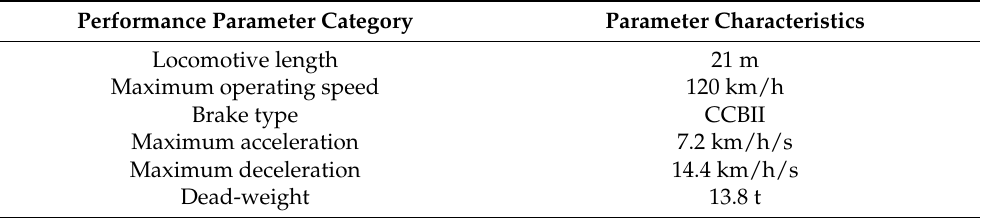
Table 6. Main parameters of